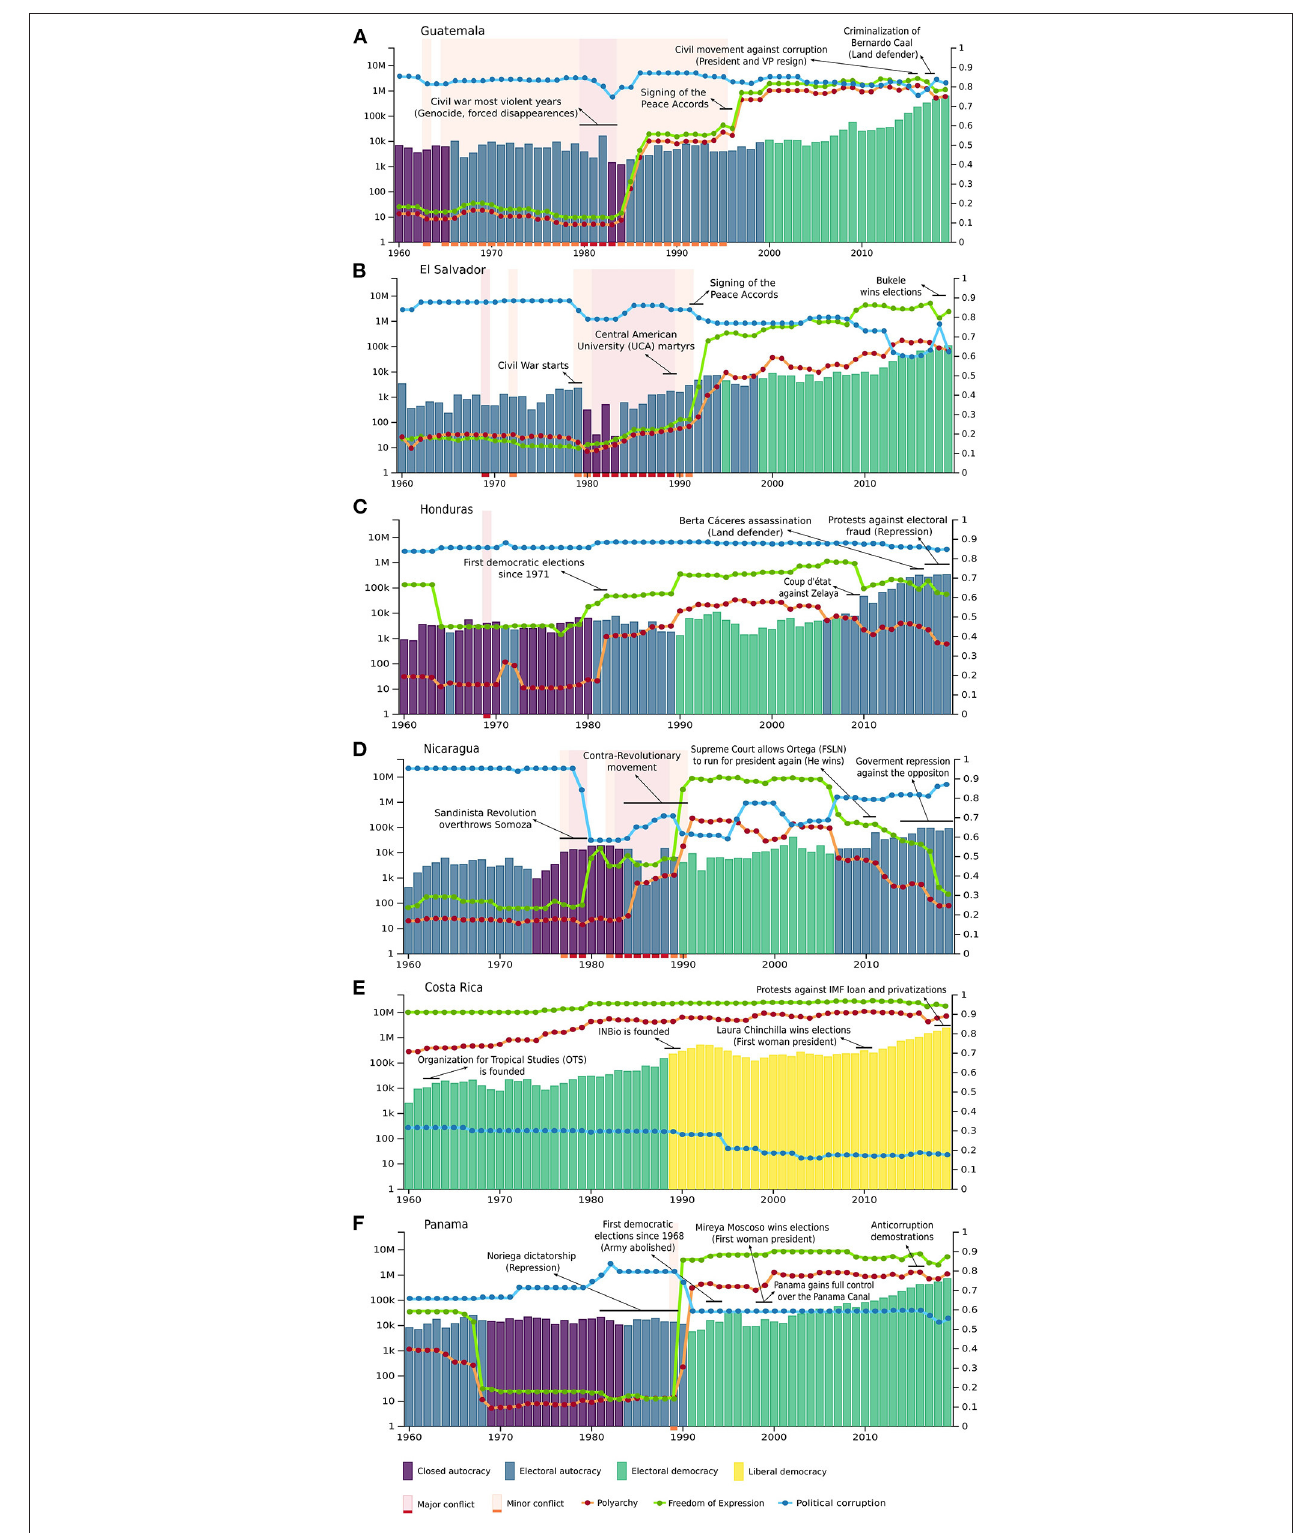
FIGURE 1 | Number of species occurrence records and socio-political variables between 1960 and 2020 in Central America (by Bio-Dem). The three socio-political variables that were considered are (1) Freedom of expression (green), (2) Political corruption (blue), and (3) Polyarchy (red). Polyarchy refers to what degree